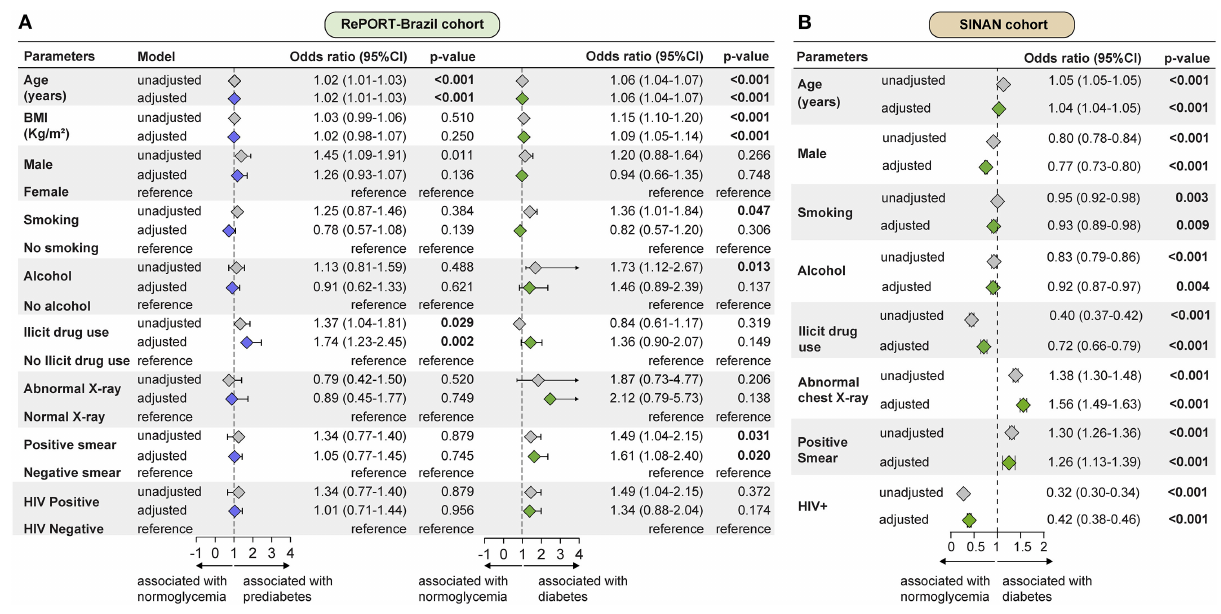
Frontiers in Medicine |